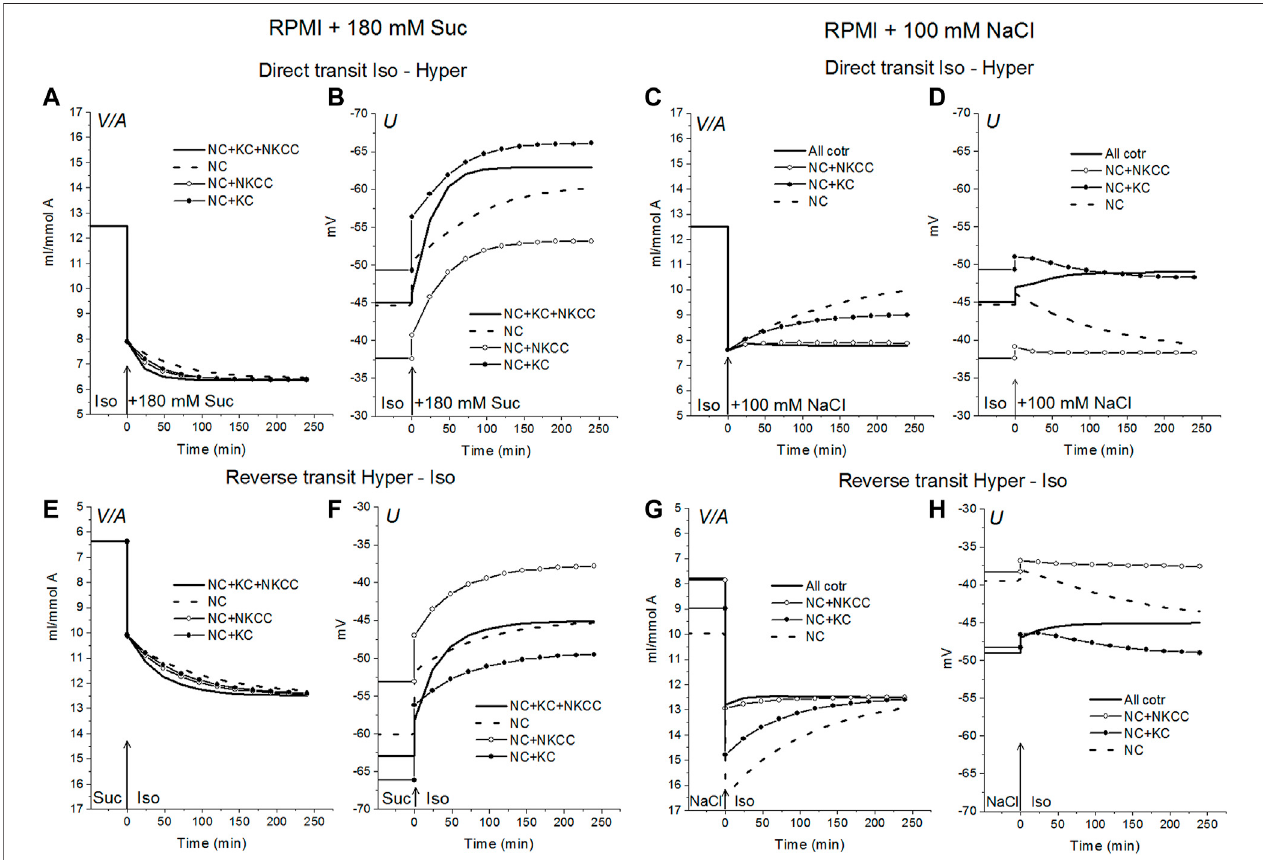
FIGURE2| Rearrangementofionichomeostasis causedbyan increase inexternalosmolarity inthe U937cell model withdifferentcotransportersand parameters likein cellsbalanced withthestandard medium.Direct Iso-Hyper (A – D) andreverseHyper-Iso (E – H) transitions. Notethatthedirectionofthevertical axes isreversedin the reverse transit